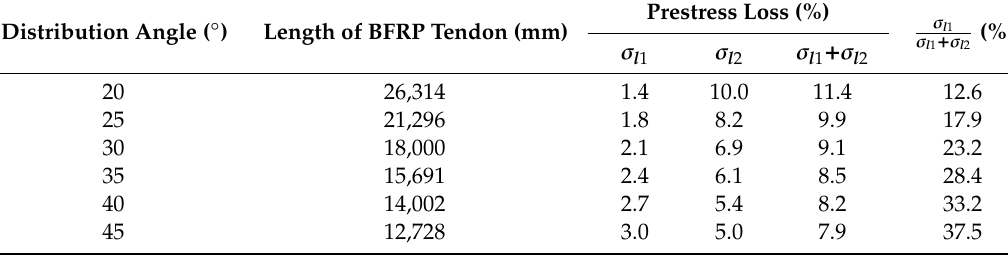
Table 4. Theoretical prestress loss of BFRP tendons given the slab width of 9.0 m. Distribution Angle ( ◦ ) Length of BFRP Tendon